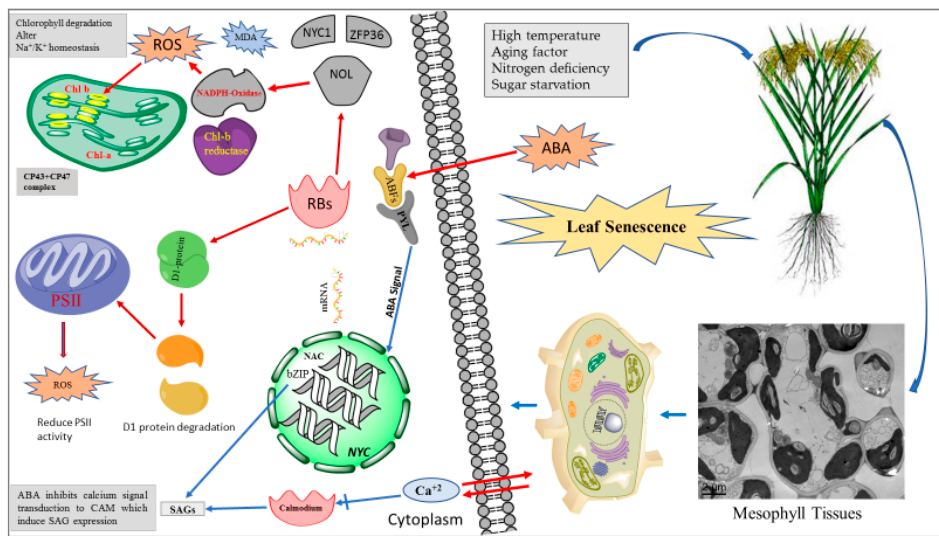
Figure 2. A schematic diagram of ABA signal transduction toward chlorophyll degradation and reduced photosynthetic activity. ( indicate induction and indicates suppression). Abiotic stresses induce ABA production, which is sensed by ABA signaling receptors (ABF, PYL). ABA signal induce expression of NAC, bZIP and NYC TFs. The activated TFs induce expression of SAGs which are translated in RBs (ribosomes) to synthesize (NOL, NADPH oxidase, Chl- b reductase). NDPH oxidase increase ROS production and Chl b reductase reduce PSII (photosystem II) efficiency and induce the degradation of D1